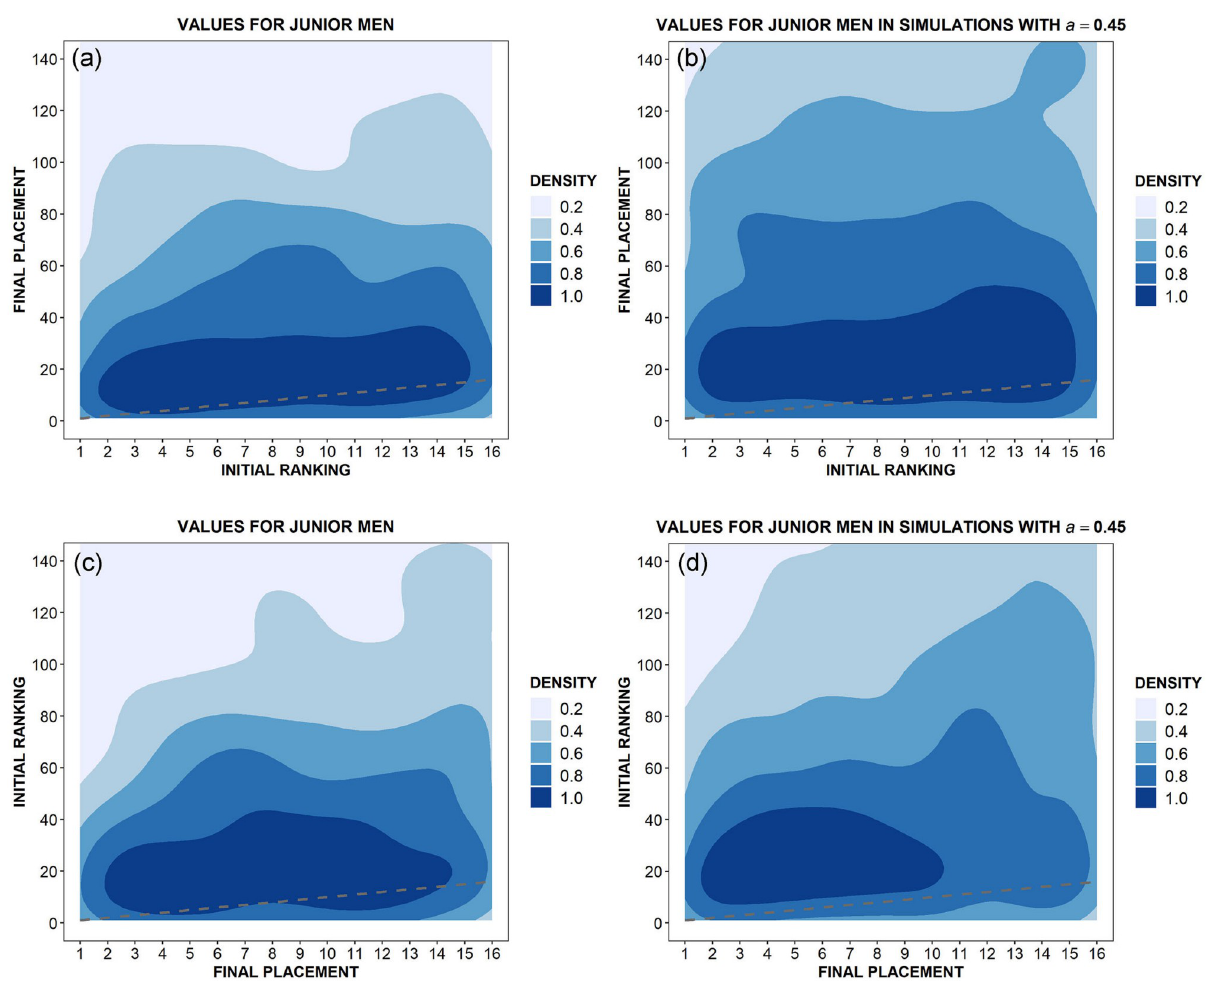
Fig 6. Single tournaments: Kernel density plots for initial ranking position versus final classification (top panels) and vice-versa (bottom panels) in both World Cups (a-c) and simulations (b-d) for male fencers. In every panel, a dashed gray line shows the ideal case in which talent would be the only variable influencing both ranking placements and tournaments’